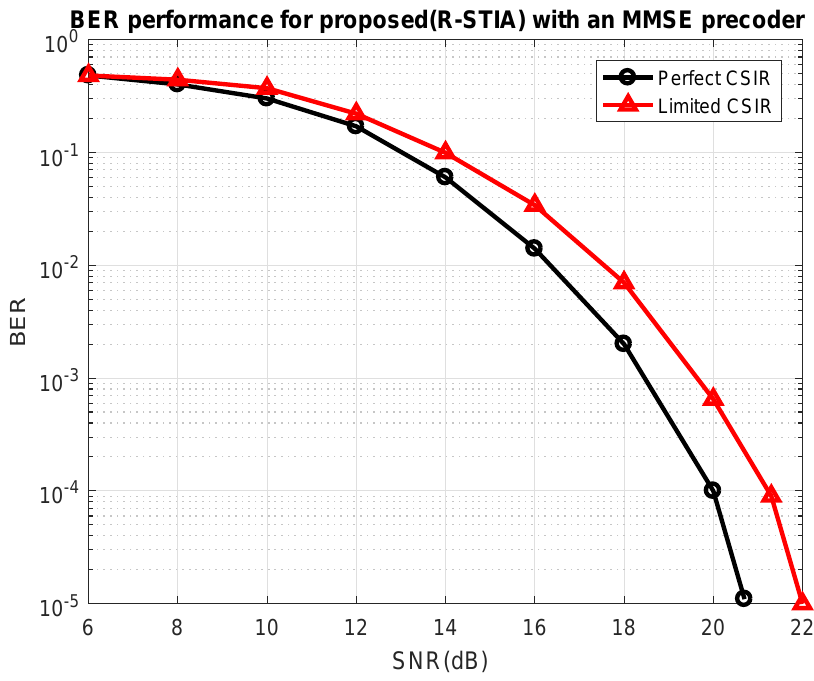
Figure 7. Bit error rate (BER) performance for proposed the relay space-time interference alignment (R-STIA) with perfect and limited channel state information at the relay (CSIR)